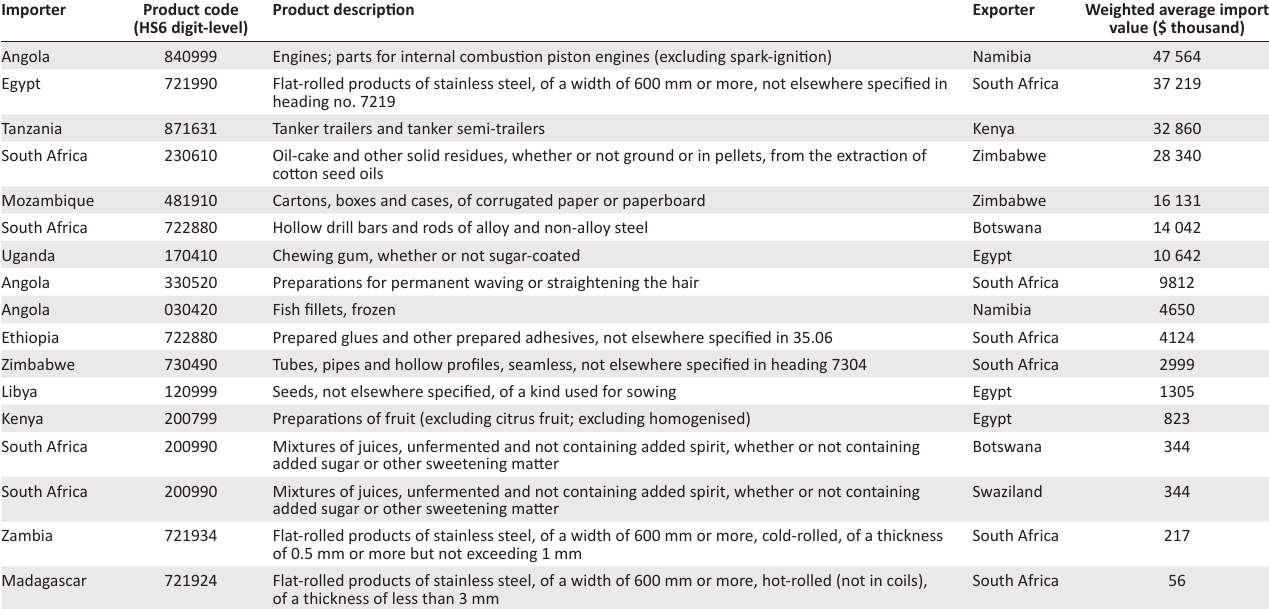
TABLE 6: Importer–product–exporter matches where trade has declined (2010–2014). Importer Product code Product description (HS6 digit-level)